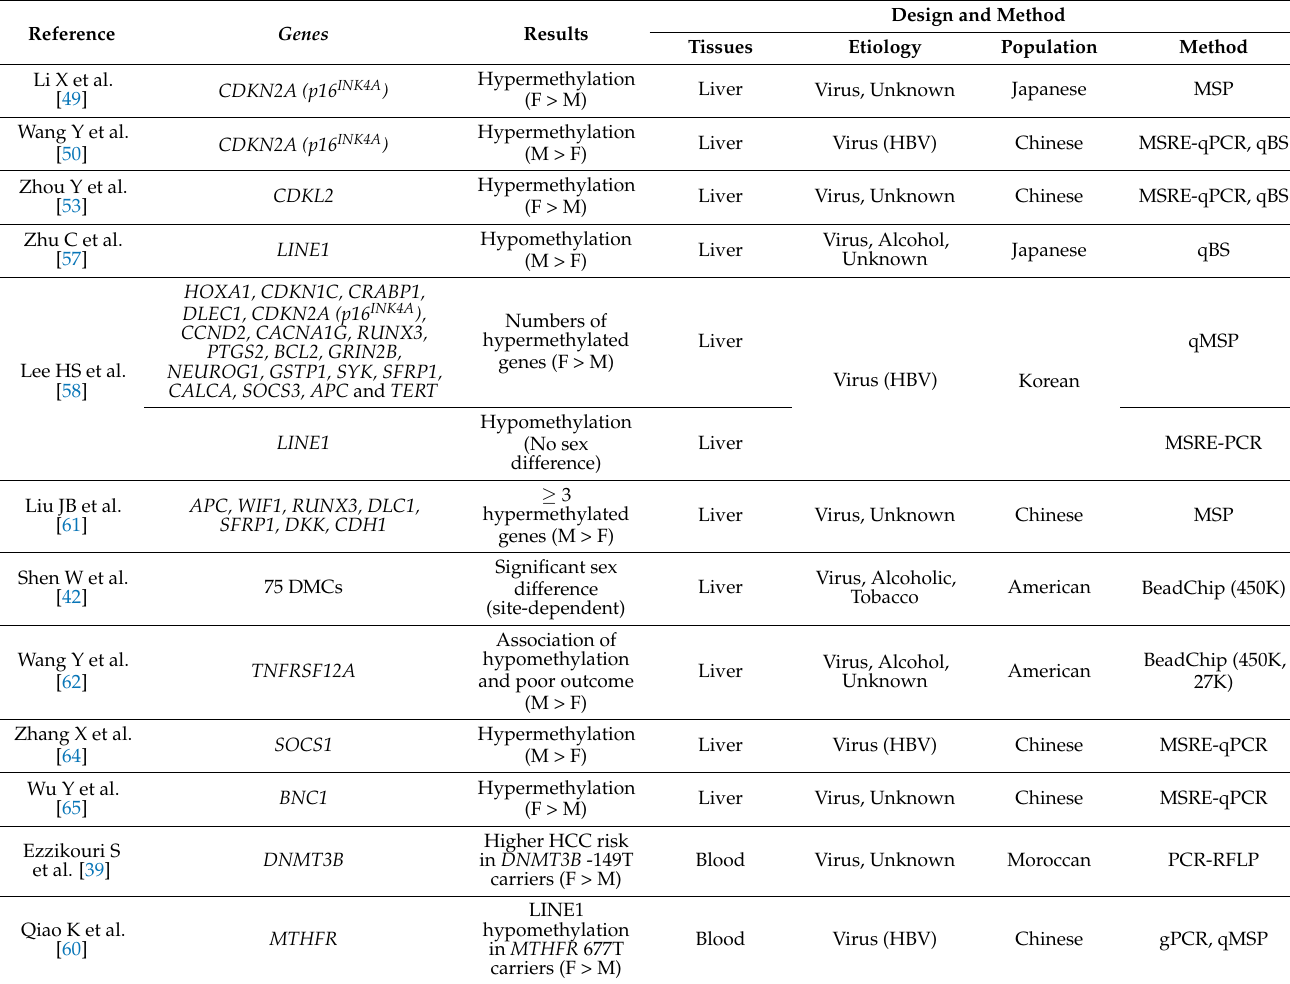
Table 2. Genes or genomic loci showing sex-related differential methylation in hepatocellular carcinoma